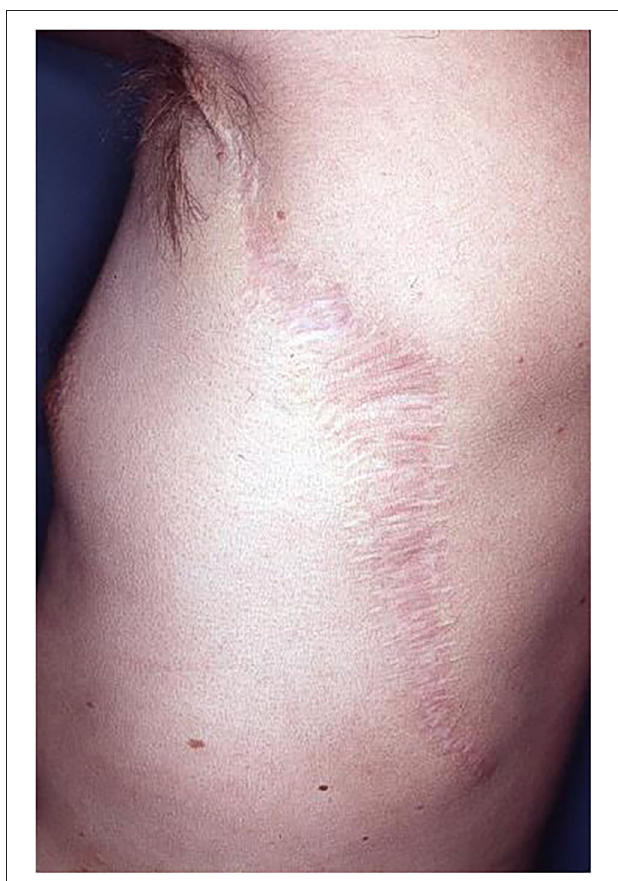
FIGURE 14 | Donor site of the patient, 2 years after harvesting of LDM.